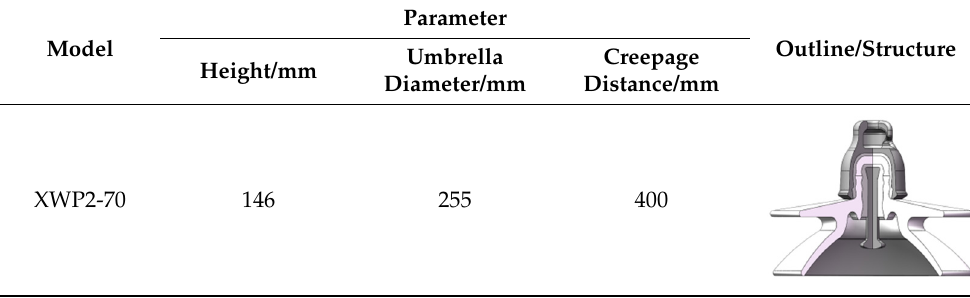
Table 2. The relative dielectric constant of each dielectric material. Dielectric material Air